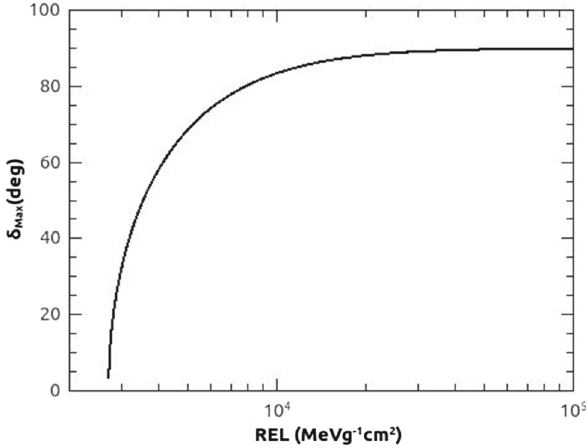
Fig. 11 The maximum angle to the normal of the NTD plane within which the HIP will be